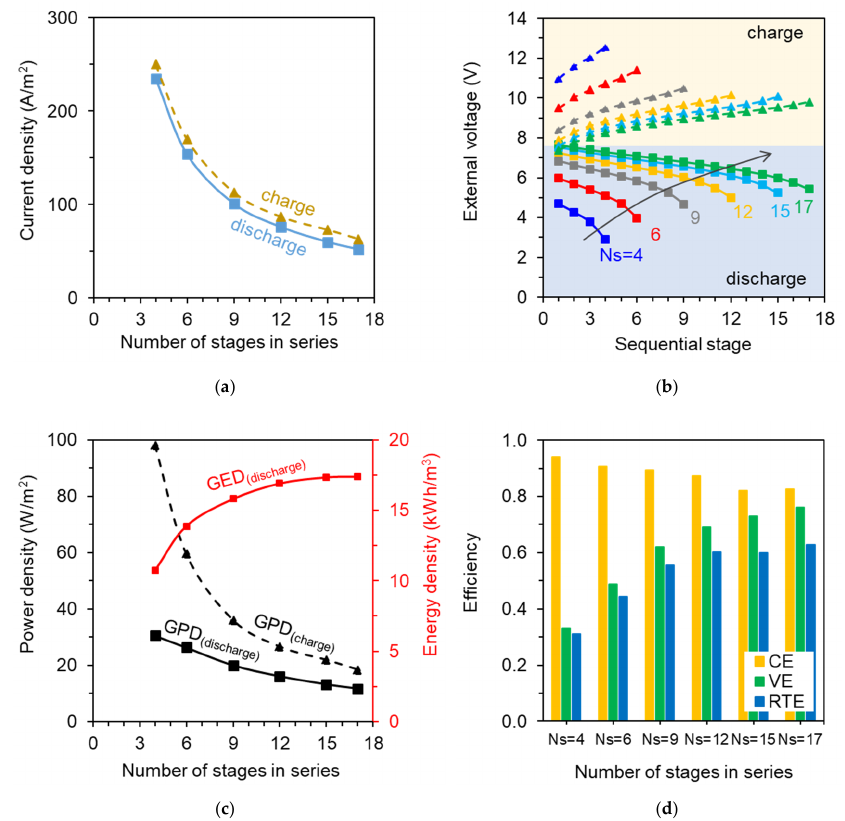
Figure 4. Model predictions of the effect of number of stages in series for an acid–base flow battery system: ( a ) charge and discharge current density (fixed equal for all stages); ( b ) profiles of charge /